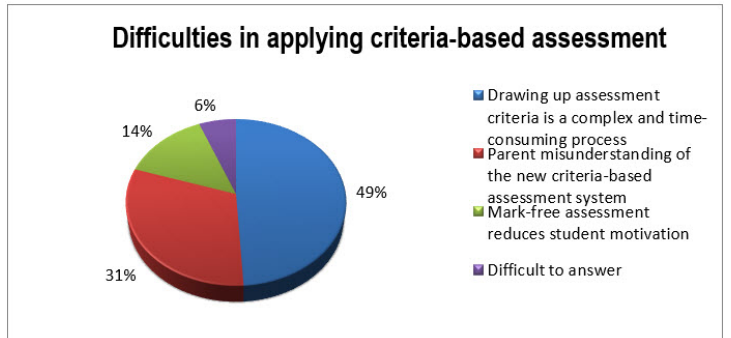
Figure 3. Impact on education in the field of criteria-based